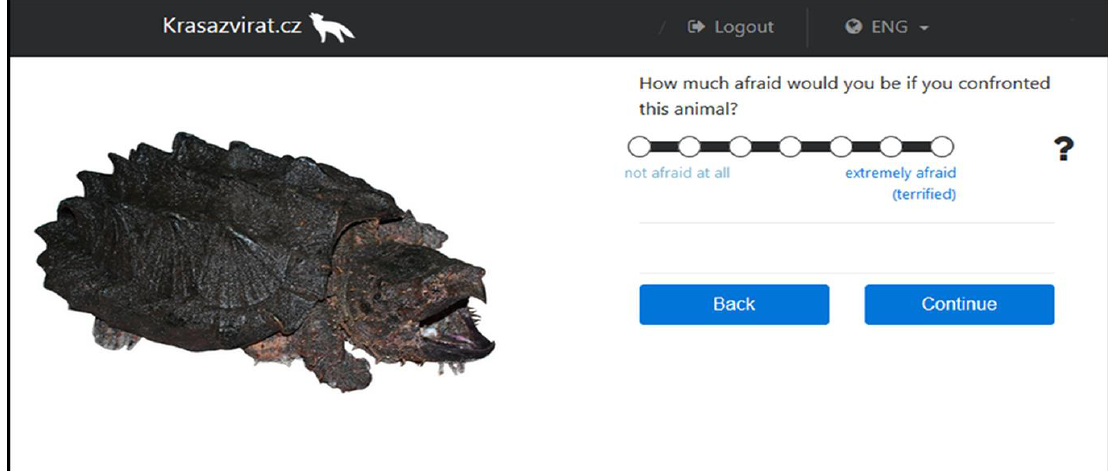
Figure 1. Sample of graphic design of web application for evaluating pictures.